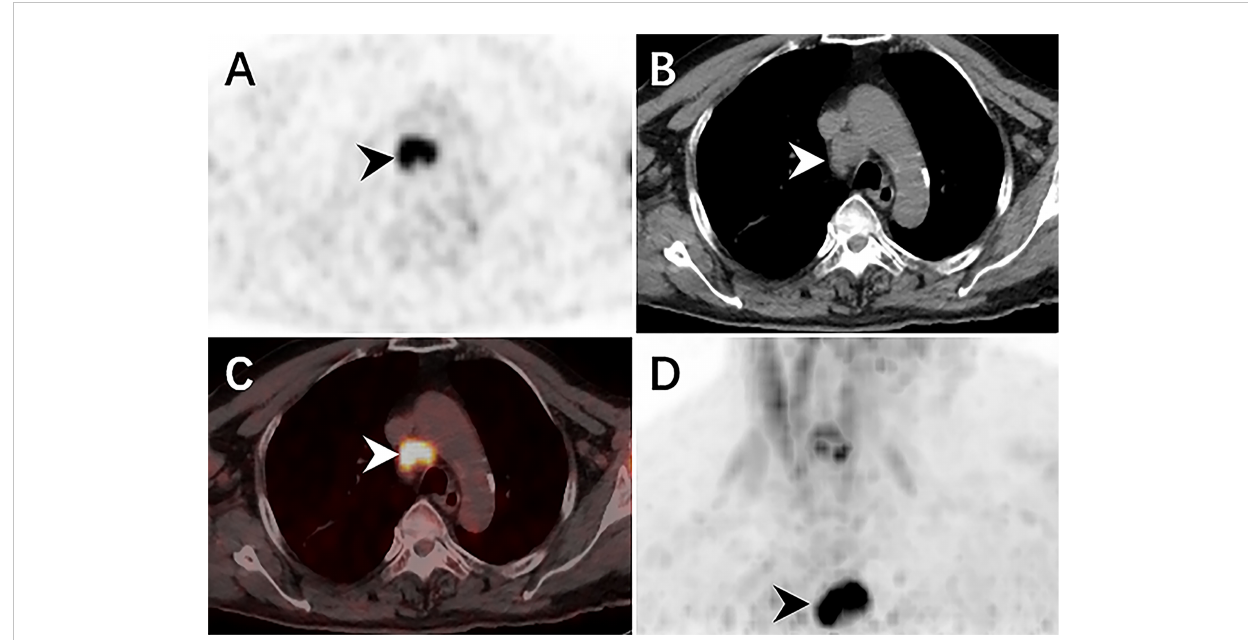
FIGURE 2 The delay 18 F-FDG PET/CT revealed elevated activity foci in the mediastinum, with a SUVmax of 7.0. The CT scan revealed a single, low-density lymph node nearby the aortic arch (arrowheads) ( A : PET, B : CT, C : fusion, D :